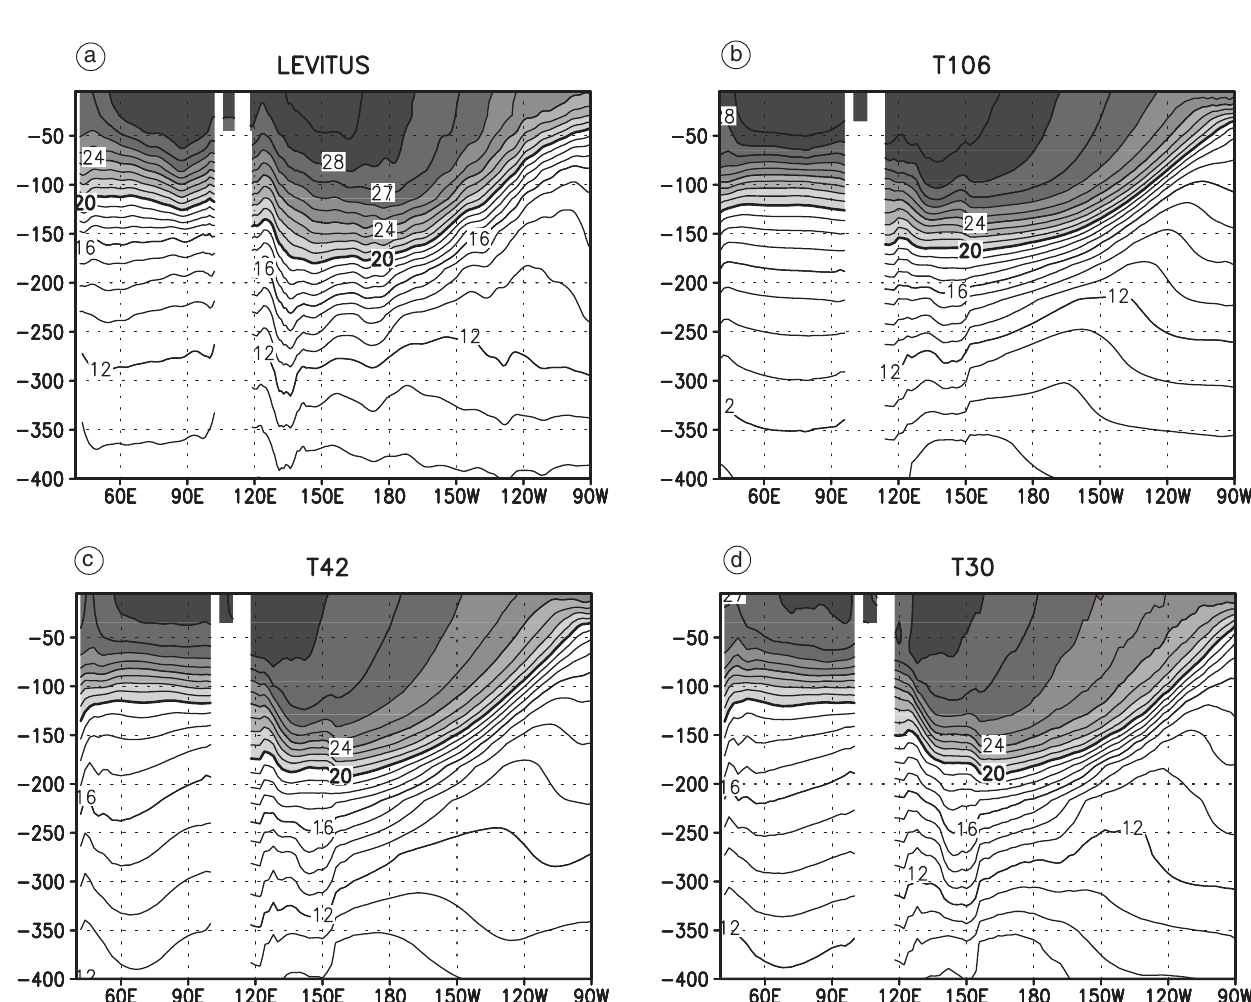
Fig. 9a-d. Vertical section of the mean temperature distribution of the upper 400 m along the equator in the Indian Ocean and Pacific. Panel a): as derived from the Levitus data set; panel b): T106 experiment; panel c): T42 experiment; panel d): T30 experiment. Contour line interval is 1 ° C. Values larger than 20 ° C are shaded; the shaded contour interval is 2 ° C. The 20 ° C isotherm is